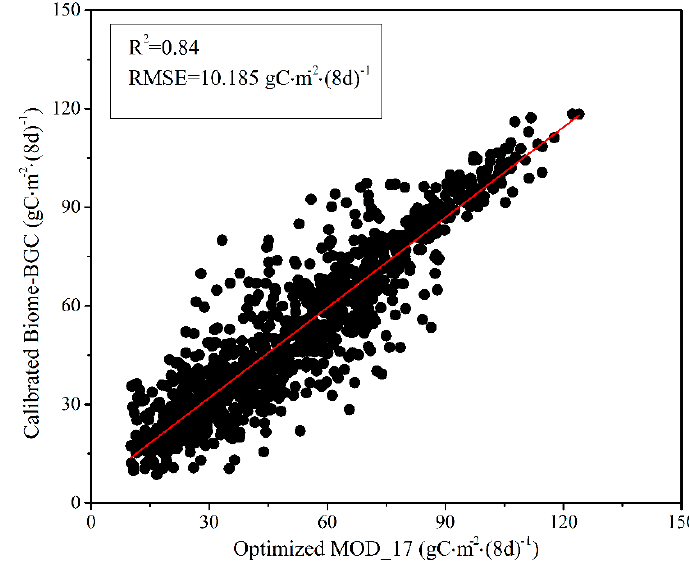
Figure 4. A comparison of eight-day GPP values for the growing season obtained using the optimized MOD_17 model and those derived from the calibrated Biome-BGC model.